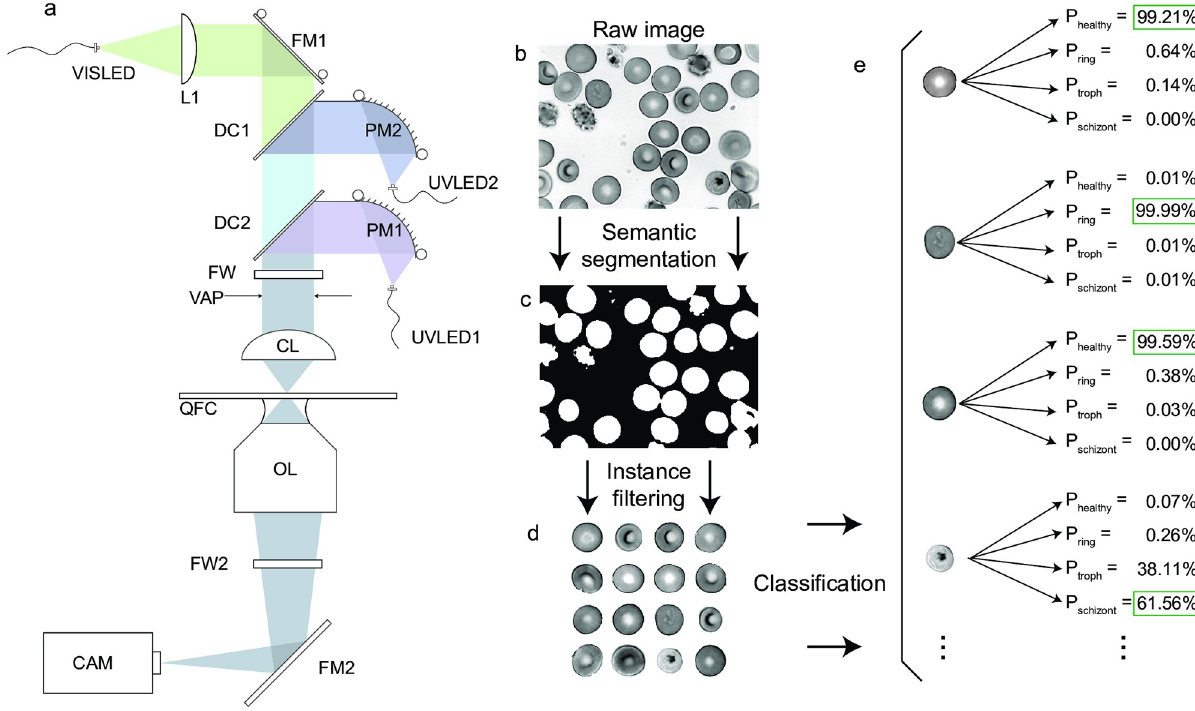
Fig 1. Overall experiment with a custom UV microscope. The deep UV microscope (a) was built in a simple transmitted light configuration using a finite conjugate objective lens (OL) to form an image on a camera (CAM) via a rigid fold mirror (FM2) without the need for a specialized tube lens. A custom condenser was built to combine three collimated LEDs (UVLED1, UVLED2, VISLED) using an adjustable fold mirror (FM1) and two dichroic mirrors (DC1, DC2). UV LEDs were collimated using parabolic mirrors (PM1, PM2). Transmitted light numerical aperture was limited with a variable aperture (VAP), then focused onto the sample using a UV fused silica condenser lens (CL). Filter wheels (FW1,2) were added for fluorescence applications (not used in this study). Samples were mounted in Quartz Flow Cells (QFC) for compatibility with deep UV imaging. b) Raw image of